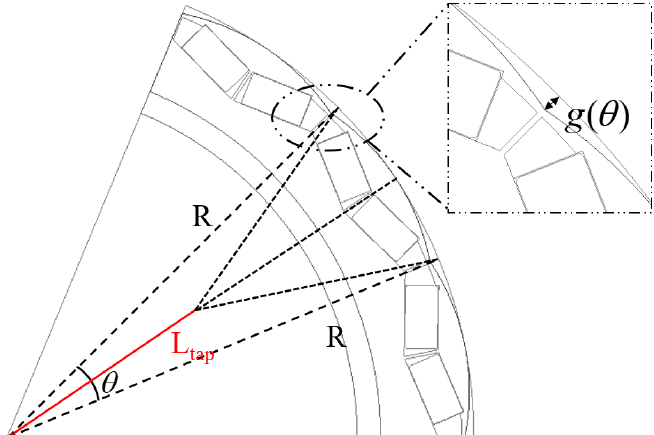
Figure 5. Tapering structural design parameters.